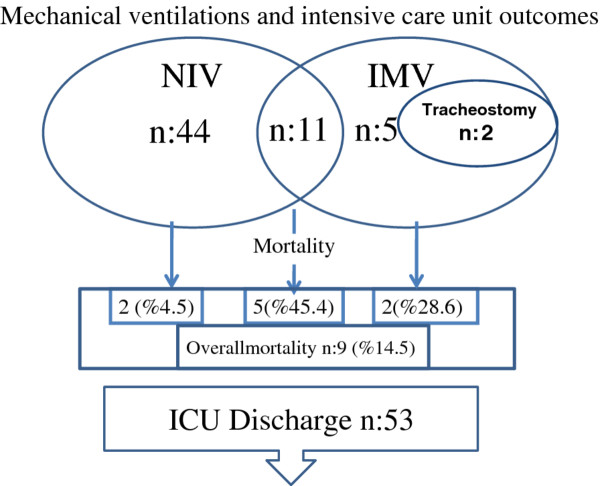
 Mechanical ventilation outcomes of kyphoscoliosis patients in intensive care unit.